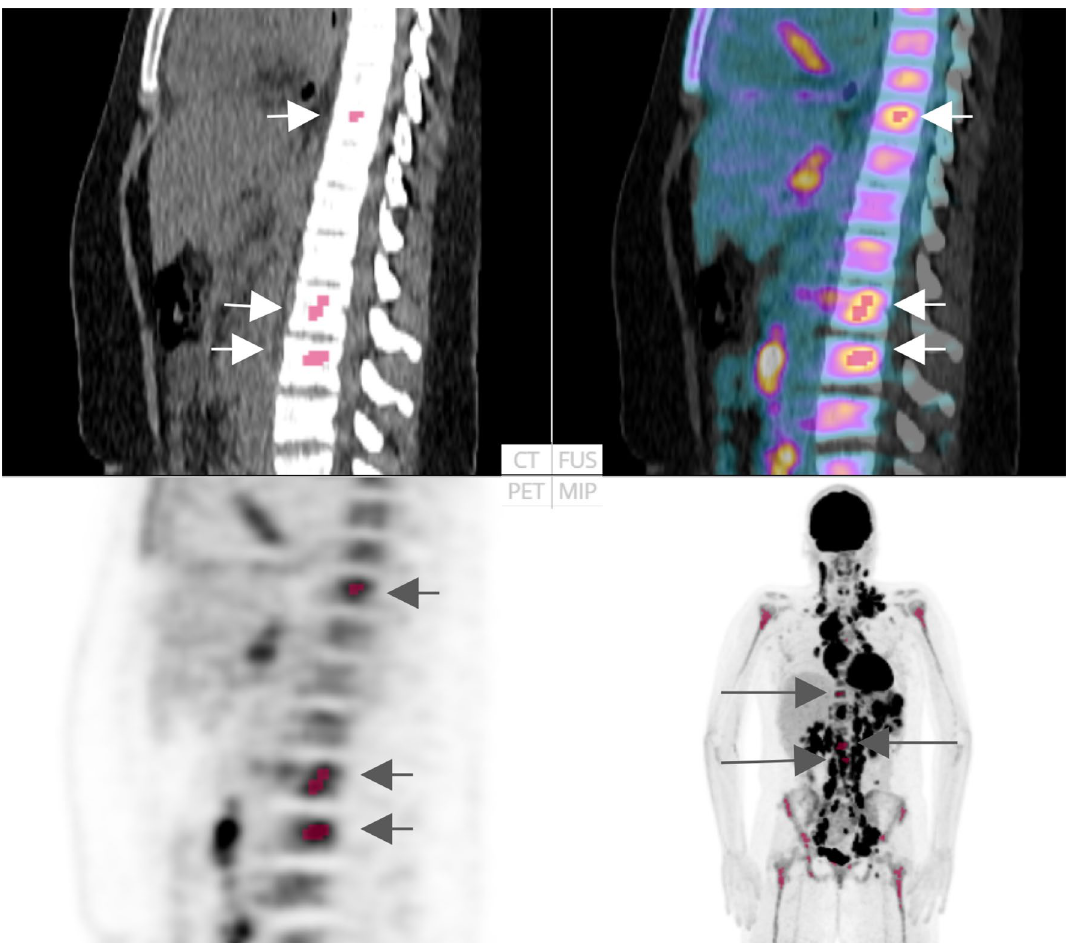
Figure 2. FDG-PET/CT: Example of a patient classified as having focal uptake in skeleton/bone marrow by the artificial intelligence-based method (highlighted in red and by arrows) and by the majority (8/10) of the